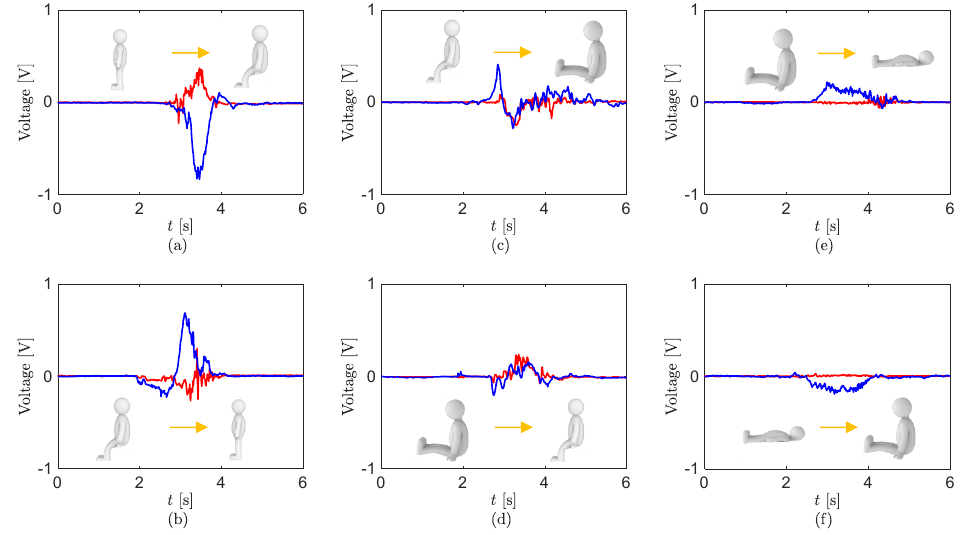
Figure 5. Digitalized sensor outputs at the transition ( a ) from the standing to sitting position; ( b ) from the sitting to standing position; ( c ) from the sitting to sitting knee extension position; ( d ) from the sitting knee extension to sitting position; ( e ) from the sitting knee extension to supine position; and ( f ) from the supine to sitting knee extension position. The red and blue lines are the data of the sensor at the knee and hip,